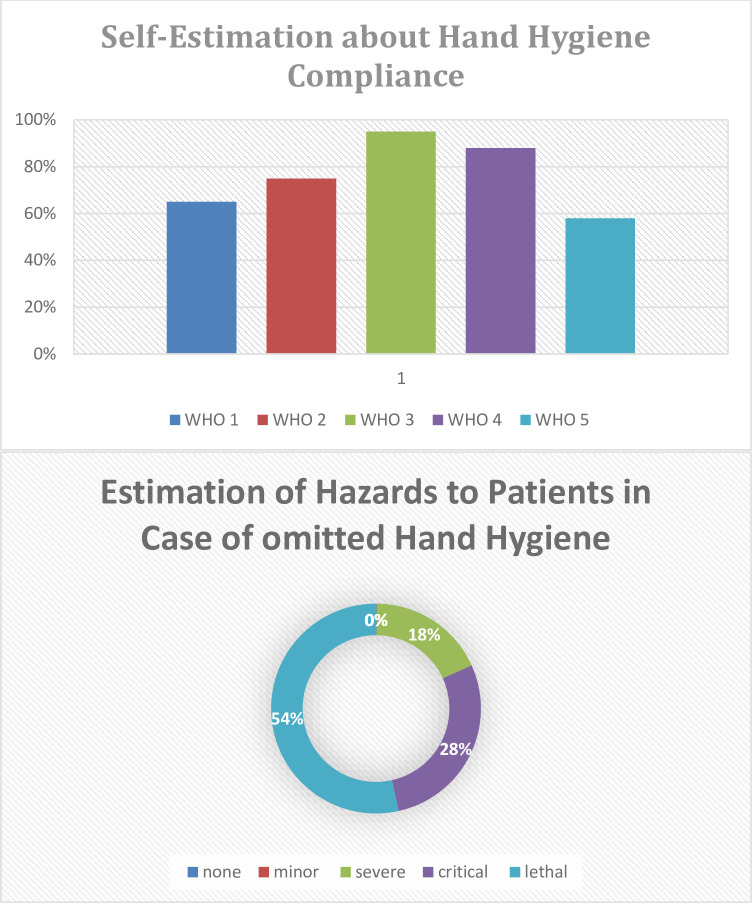
Ratings by 893 students rating themselves to adhere fairly or completely to hygiene protocols.(a) Demonstrates the self-estimations in percent of all occasions of compliance to WHO- indications with WHO 1(before touching a patient), WHO 2 (Before aseptic procedures), WHO 3 (after possible contamination), WHO 4 (after touching a patient) and WHO 5 (after contact to the patient’s environment). (b) Shows for the same students their reflexing about the maximum possible hazard to a patient in case of an omitted hand disinfection: None (no harm), minor (no sustaining harm, no longer hospital stay), severe (no sustaining harm, but longer hospital stay), critical (life-long impairment) and lethal (death or permanent brain damage).